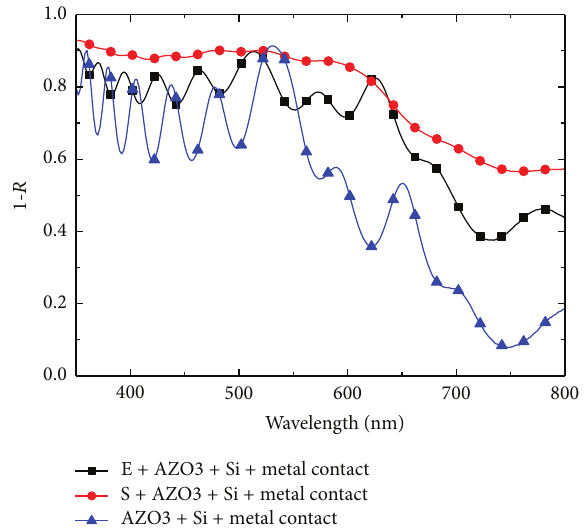
Figure 10: ( 1 − 𝑅 ) spectra for smooth glass, texture E, and texture S with AZO3/a-Si:H